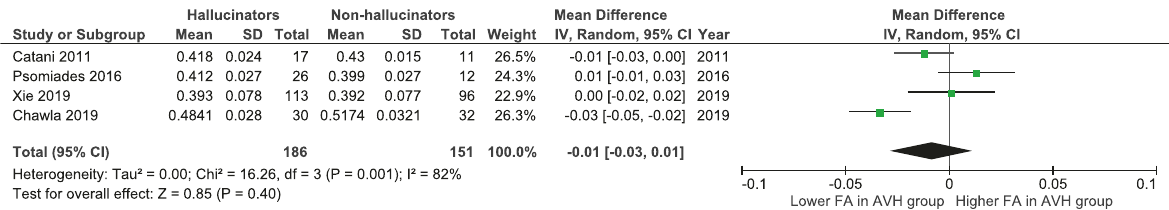
Fig. 5 A forest plot showing no signi fi cant difference between hallucinators and non-hallucinators for the fractional anisotropy of the right arcuate fasciculus. SD standard deviation, IV inverse variance, CI con fi dence interval, FA fractional